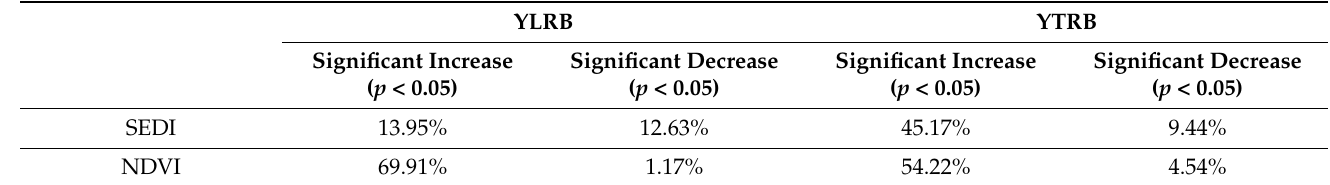
Table 2. Proportions of areas with significantly increased and decreased SEDI and NDVI values.